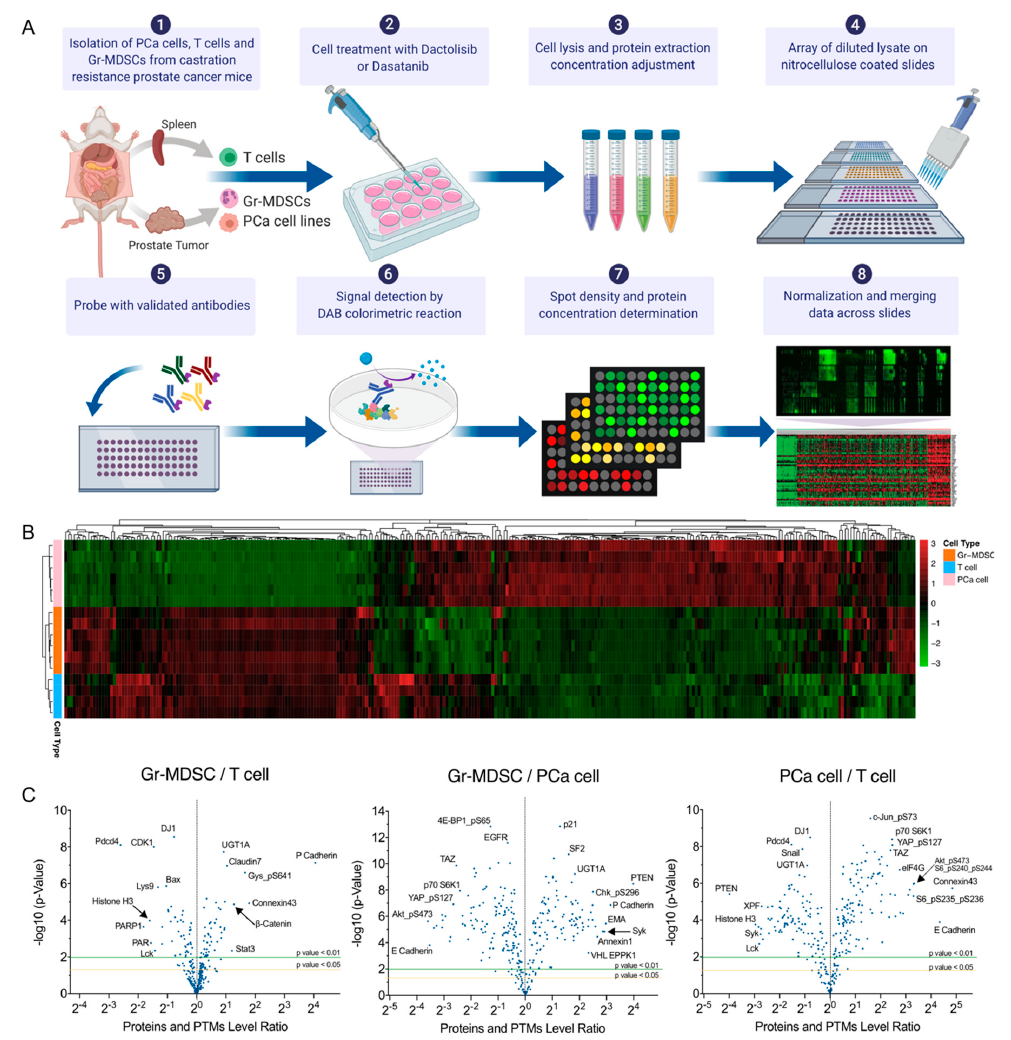
Figure 1. RPPA profiling of PCa cells, Gr-MDSCs and T cells of the CPPSML model of CRPC. ( A ) Workflow of cell isolation and RPPA. The figure was created with BioRender.com. ( B ) Unsupervised hierarchical clustering of PCa cells, T cells and Gr-MDSCs (untreated or DMSO-treated) with normalized RPPA signals. Each row represents a biological replicate sample and each column corresponds to an antibody in the RPPA array. ( C ) Volcano plots showing the pairwise fold change comparisons of the normalized protein or PTM levels among the three cell types. p values were calculated by Student’s t -test. Arrows help to pinpoint proteins of interest of whose labels were partly overlapped with adjacent